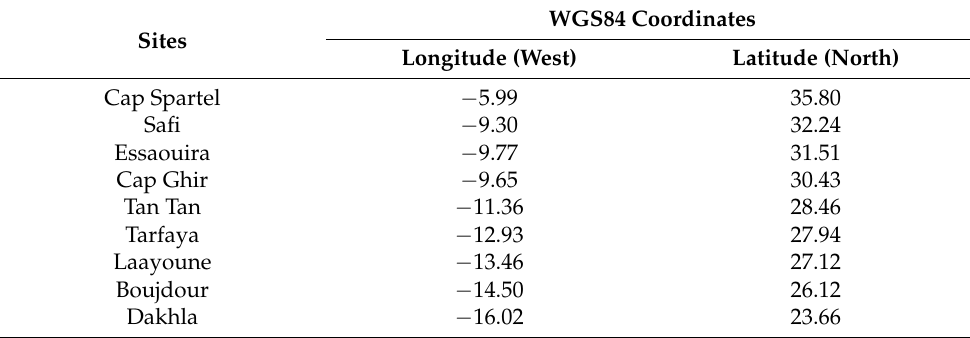
Table 2. Geographic information of the selected sites.